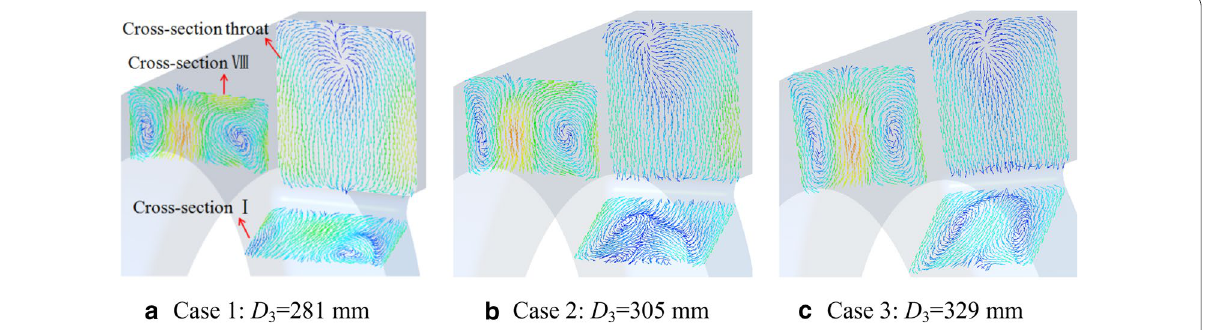
Figure 9 Tangential components of velocity at cross-sections at nominal flow